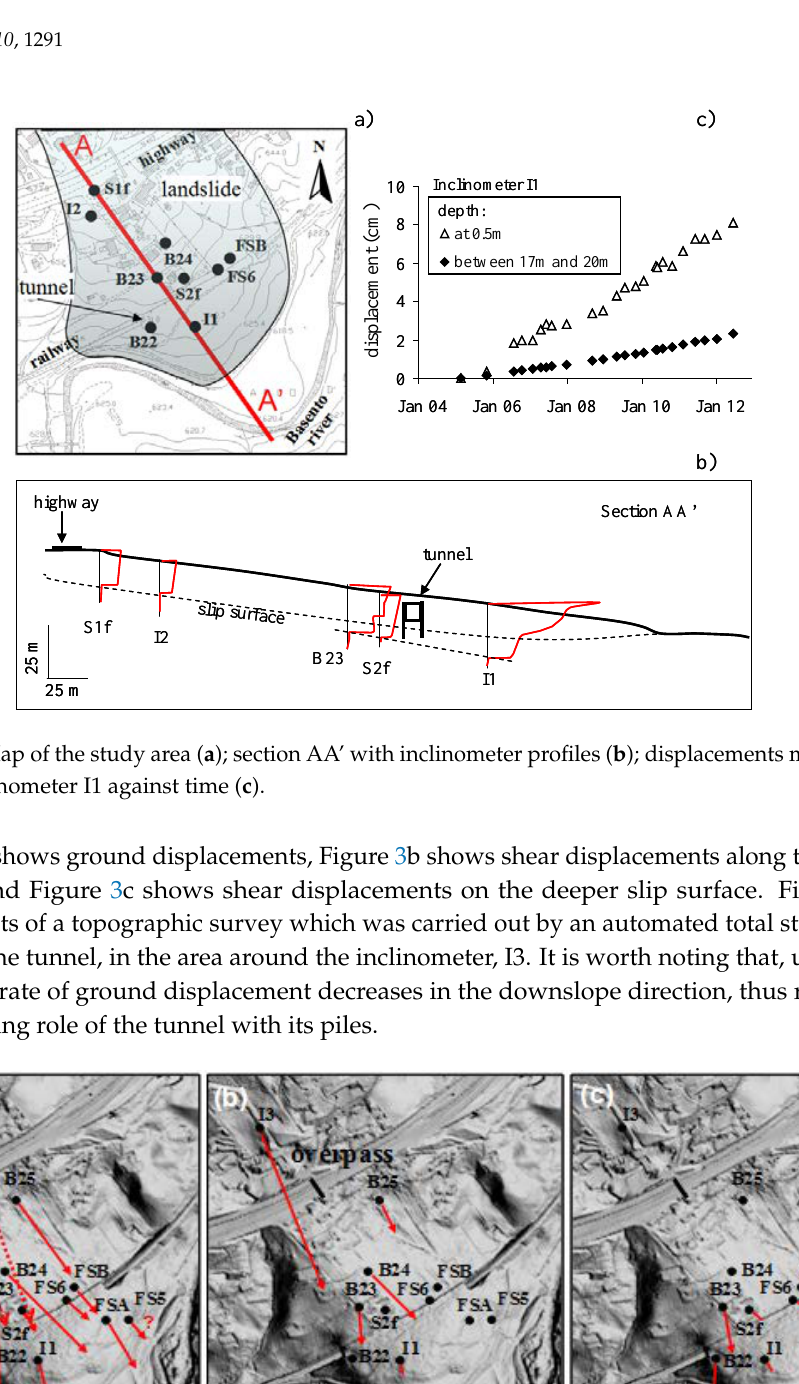
Figure 3. Displacement rate field relative to; ( a ) ground displacements obtained from inclinometer measurements (continuous lines) and theodolite measurements (dotted lines); ( b ) shear displacements along the shallower slip surface; ( c ) shear displacements along the deeper slip surface.